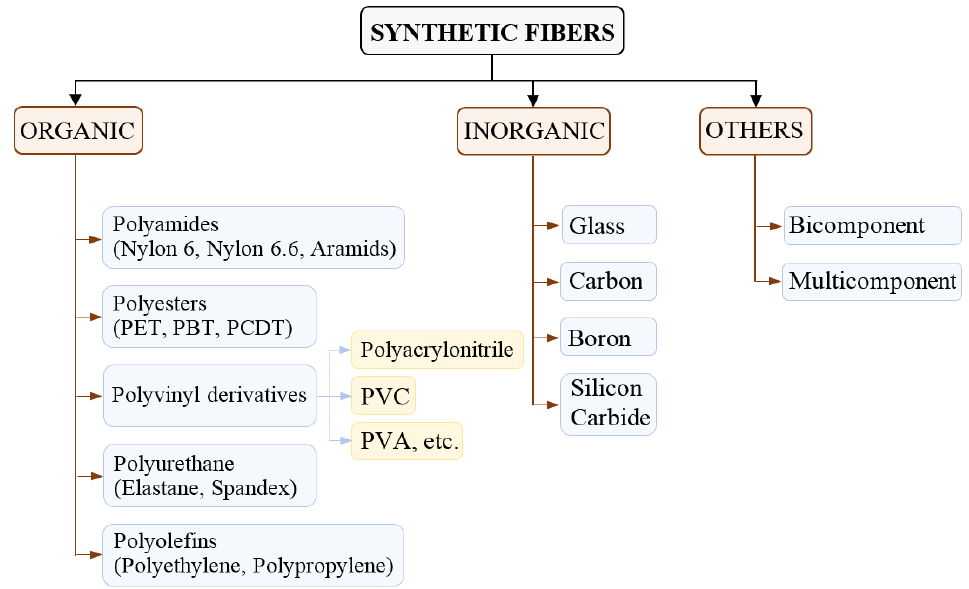
Figure 1. Classification of synthetic fibers based on organic, inorganic, and other fibers.